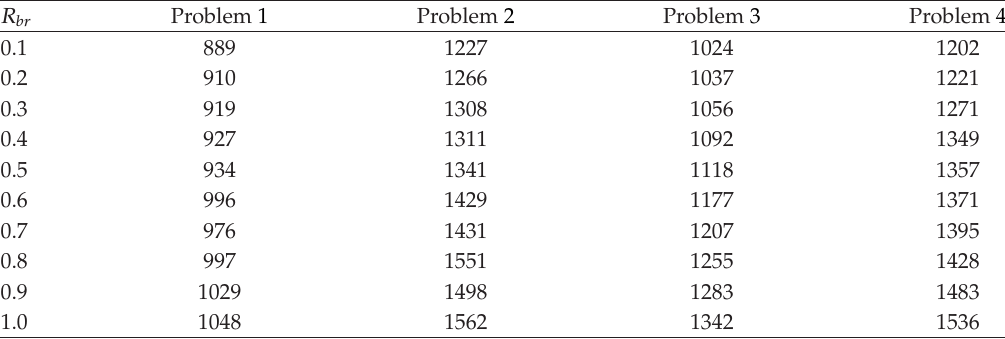
Table 10: The e ff ect of the rank-based ratio on the convergence speed of the